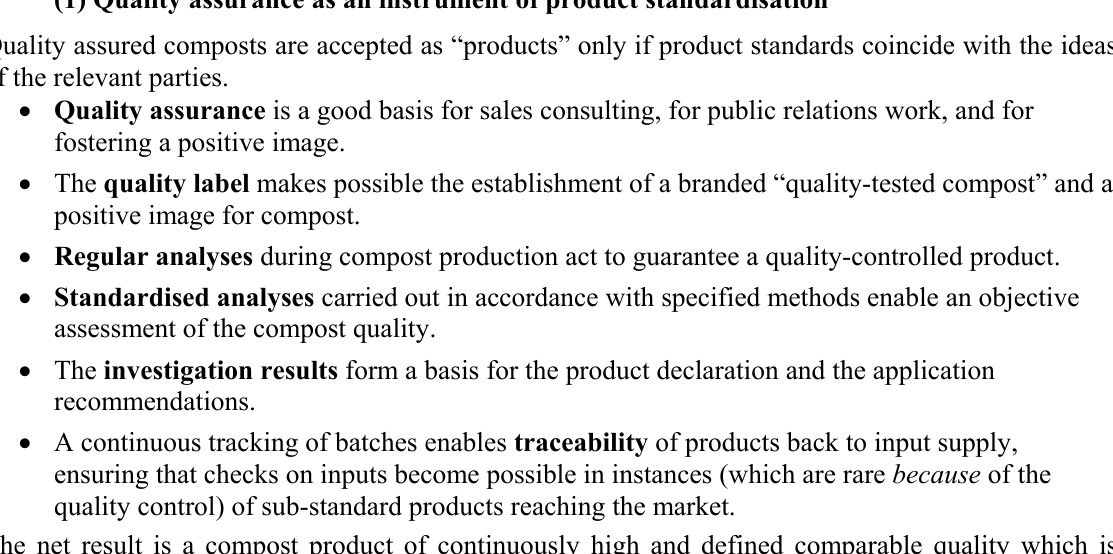
Figure 12: Quality assu- rance schemes QAS are essential parts of the organic loop, as essential as the technology or the